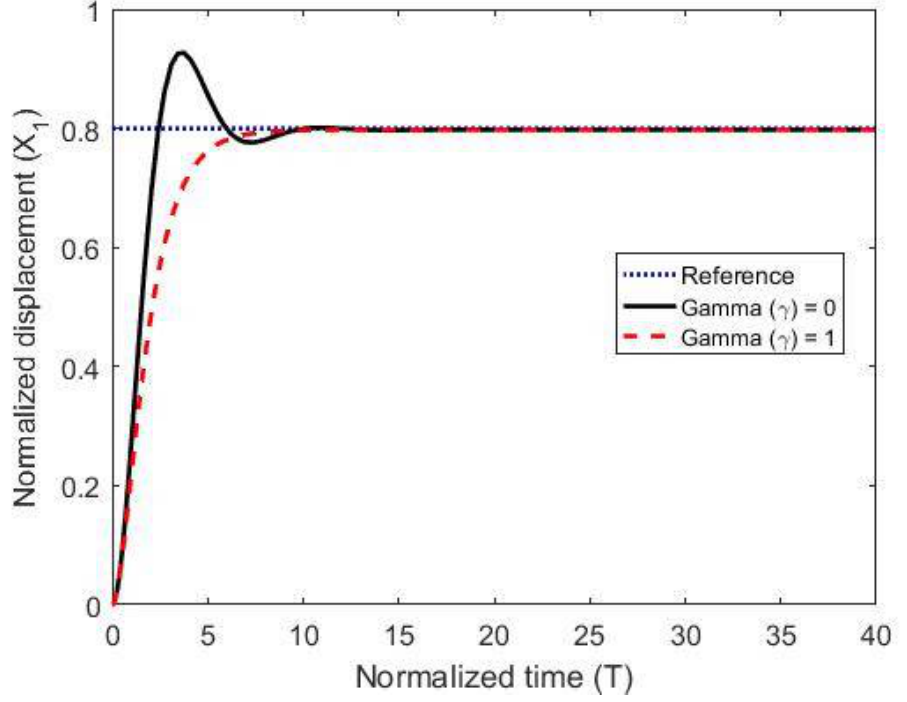
Figure 4. The normalized displacement with and without the coupling constant at a gap distance of 0.5.